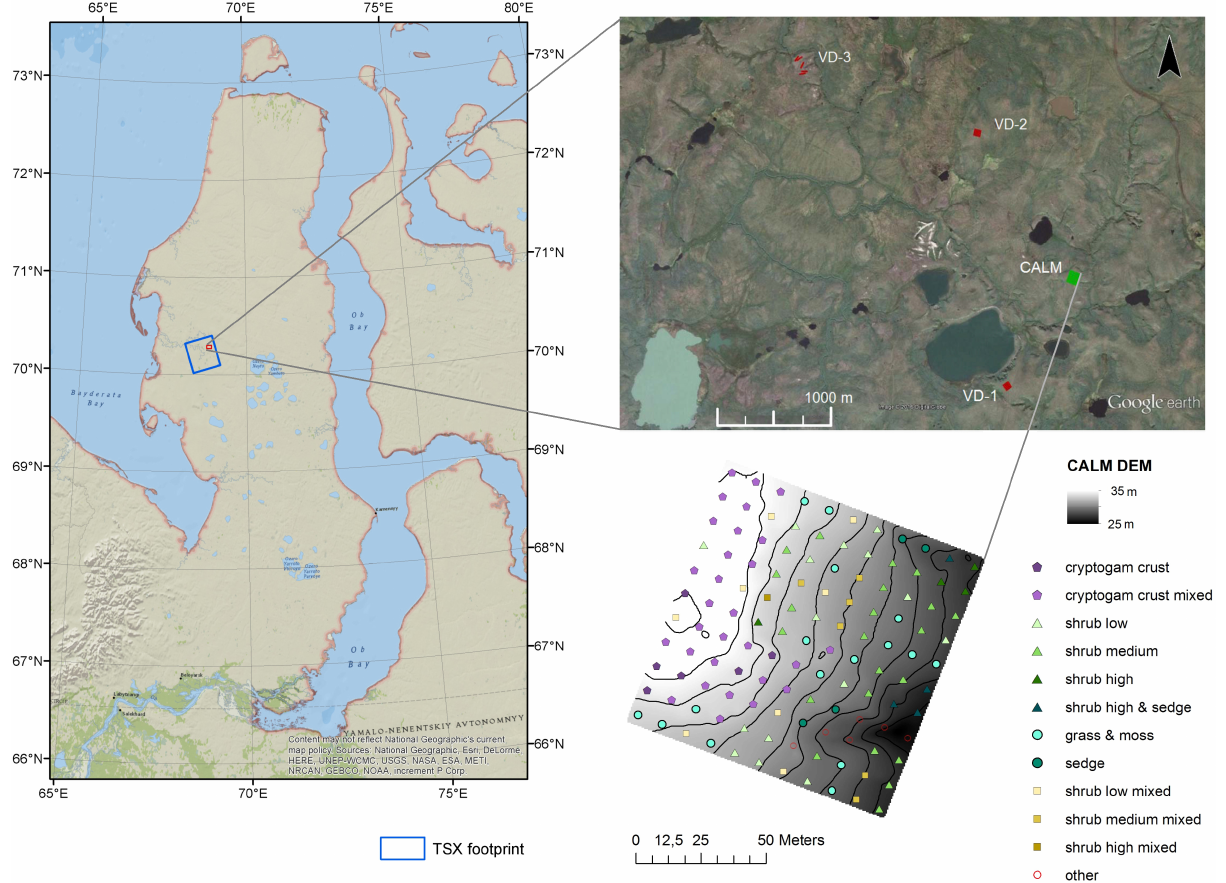
Figure 1. Location of the study area (with monitoring sites Vaskiny Dachi (VD) 1–3 and CALM gird) within the Yamal Peninsula and CALM grid DEM with land cover information (sources left: ArcMap Basemaps: National Geographic, Esri, DeLorme, HERE, UNEP- WCMC, USGS, NASA, ESA, METI, NRCAN, GEBCO, NOAA, Increment P Corp. Source top right: Google Earth, Image © 2016 Digital Globe. Bottom right: DEM (Dvornikov et al., 2016), land cover information from vegetation survey of August 2015).